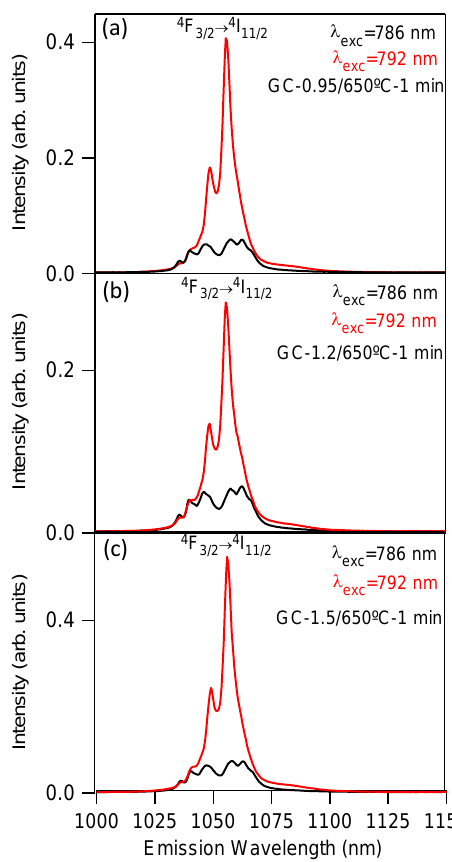
Figure 6. Room-temperature emission spectra of the 4 F 3/2 → 4 I 11/2 laser transition obtained under excitation at 786 (black) and 792 nm (red) for ( a ) GC-0.95, ( b ) GC-1.2, and ( c ) GC-1.5 samples doped with 0.1 mol% of Nd 3+ .